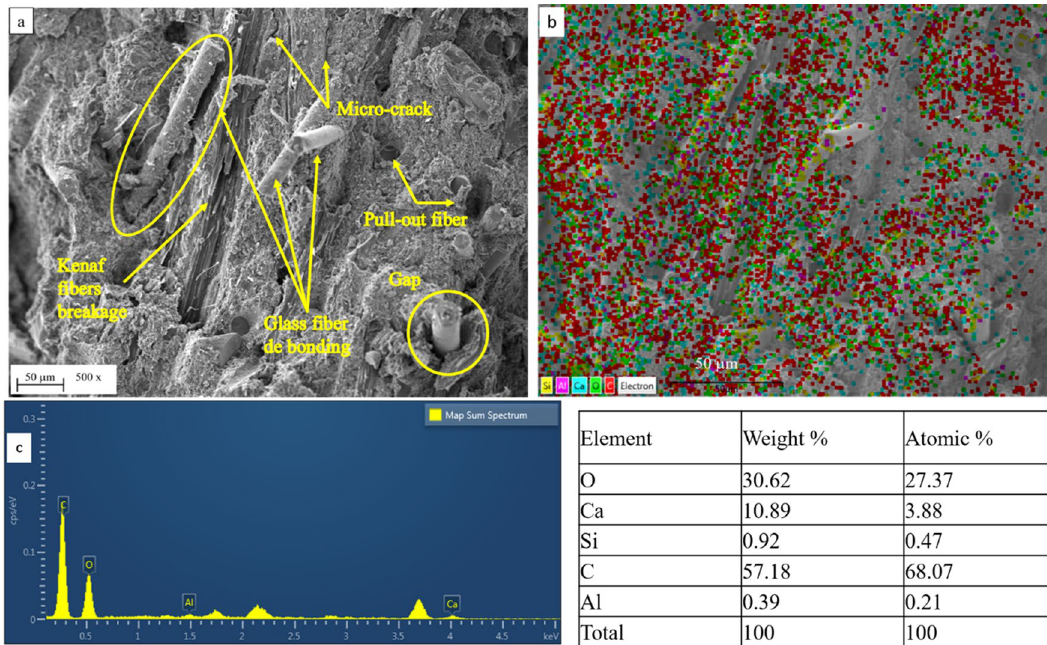
Figure 17. SEM–EDS elemental mapping of flexural fractures in the MCC0 composite, where ( a ) SEM micrographs of flexural fracture on the surface, ( b ) EDS elemental map of composition, and ( c ) EDS spectrum and right table of the atomic and weight percentages of various elements.